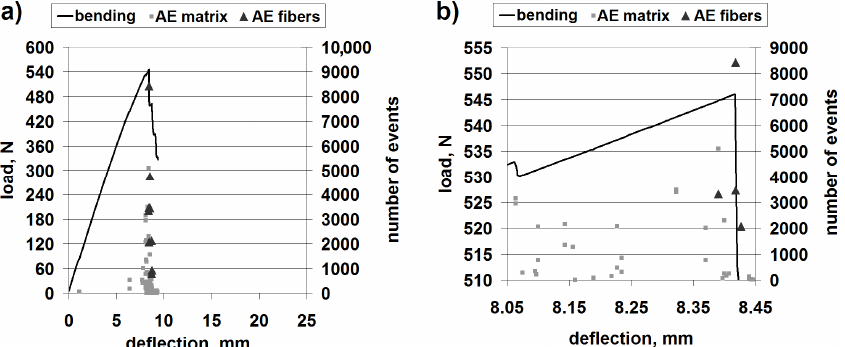
Figure 4. Mechanical curve and separated acoustic emission (AE) signal for the classic laminate: ( a ) The whole progress; ( b ) Magnification of the crucial fragment.